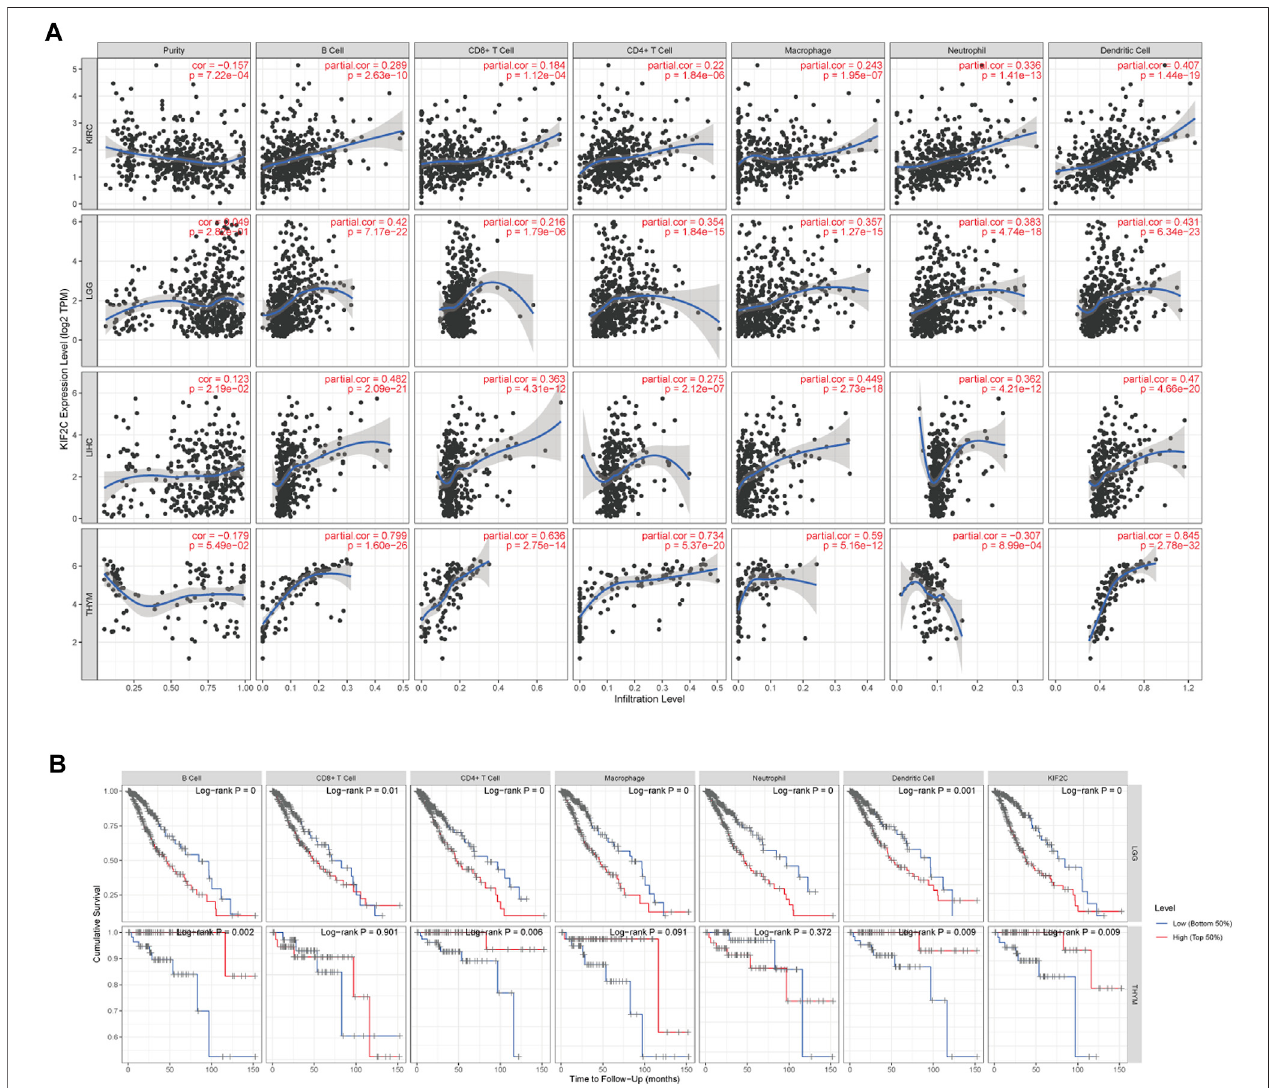
FIGURE 6 | (A) Correlation of KIF2C expression with immune in fi ltration level in KIRC, LGG, LIHC and THYM. (B) KM analysis of immune cells in fi ltration levels and expression levels of KIF2C in LGG and